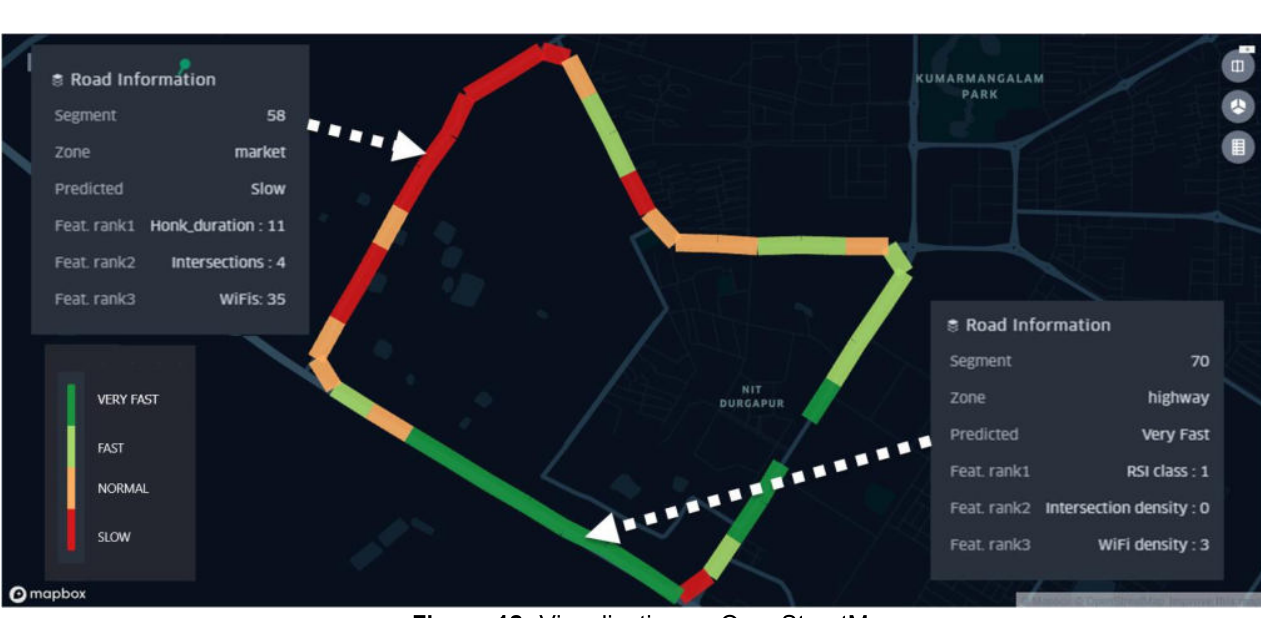
Figure 12. Visualization on OpenStreetMap